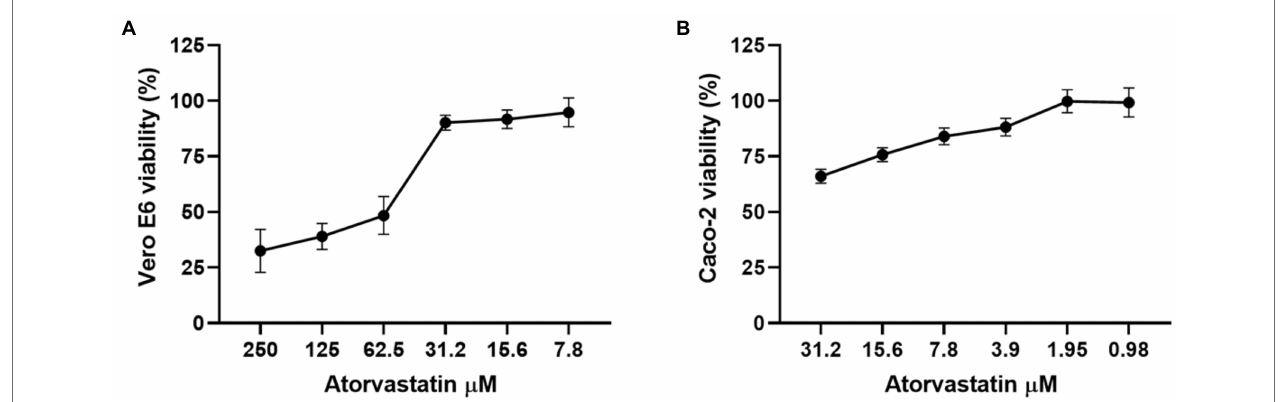
FIGURE 1 | Atorvastatin did not affect the cell viability of Vero E6 and Caco-2. Viability of Vero E6 (A) and Caco-2 (B) after 48 h of atorvastatin treatment. Data were presented as Mean ± SEM. The viability percentages of the treated cell were calculated based on untreated control. Two independent experiments with four replicates each were performed ( n =